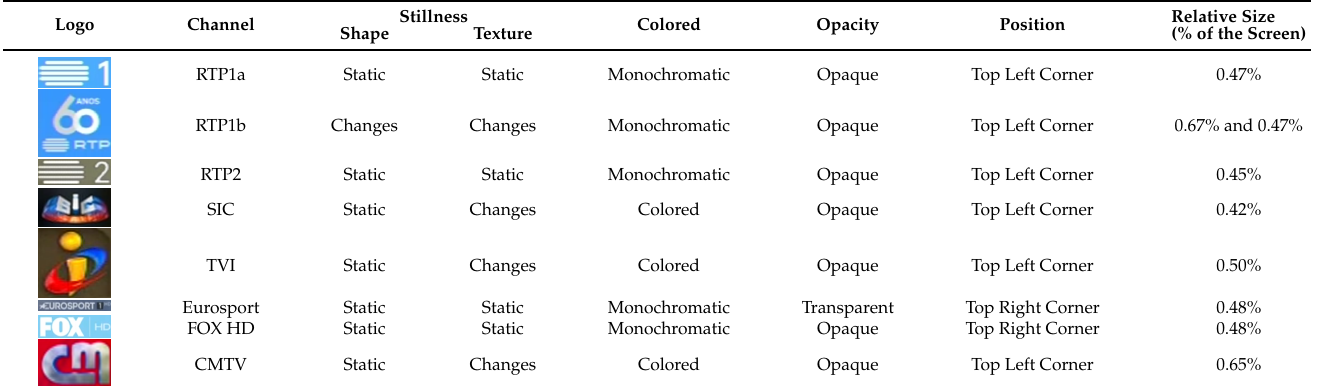
Table 3. Description of the general characteristics of the logos in the annotated